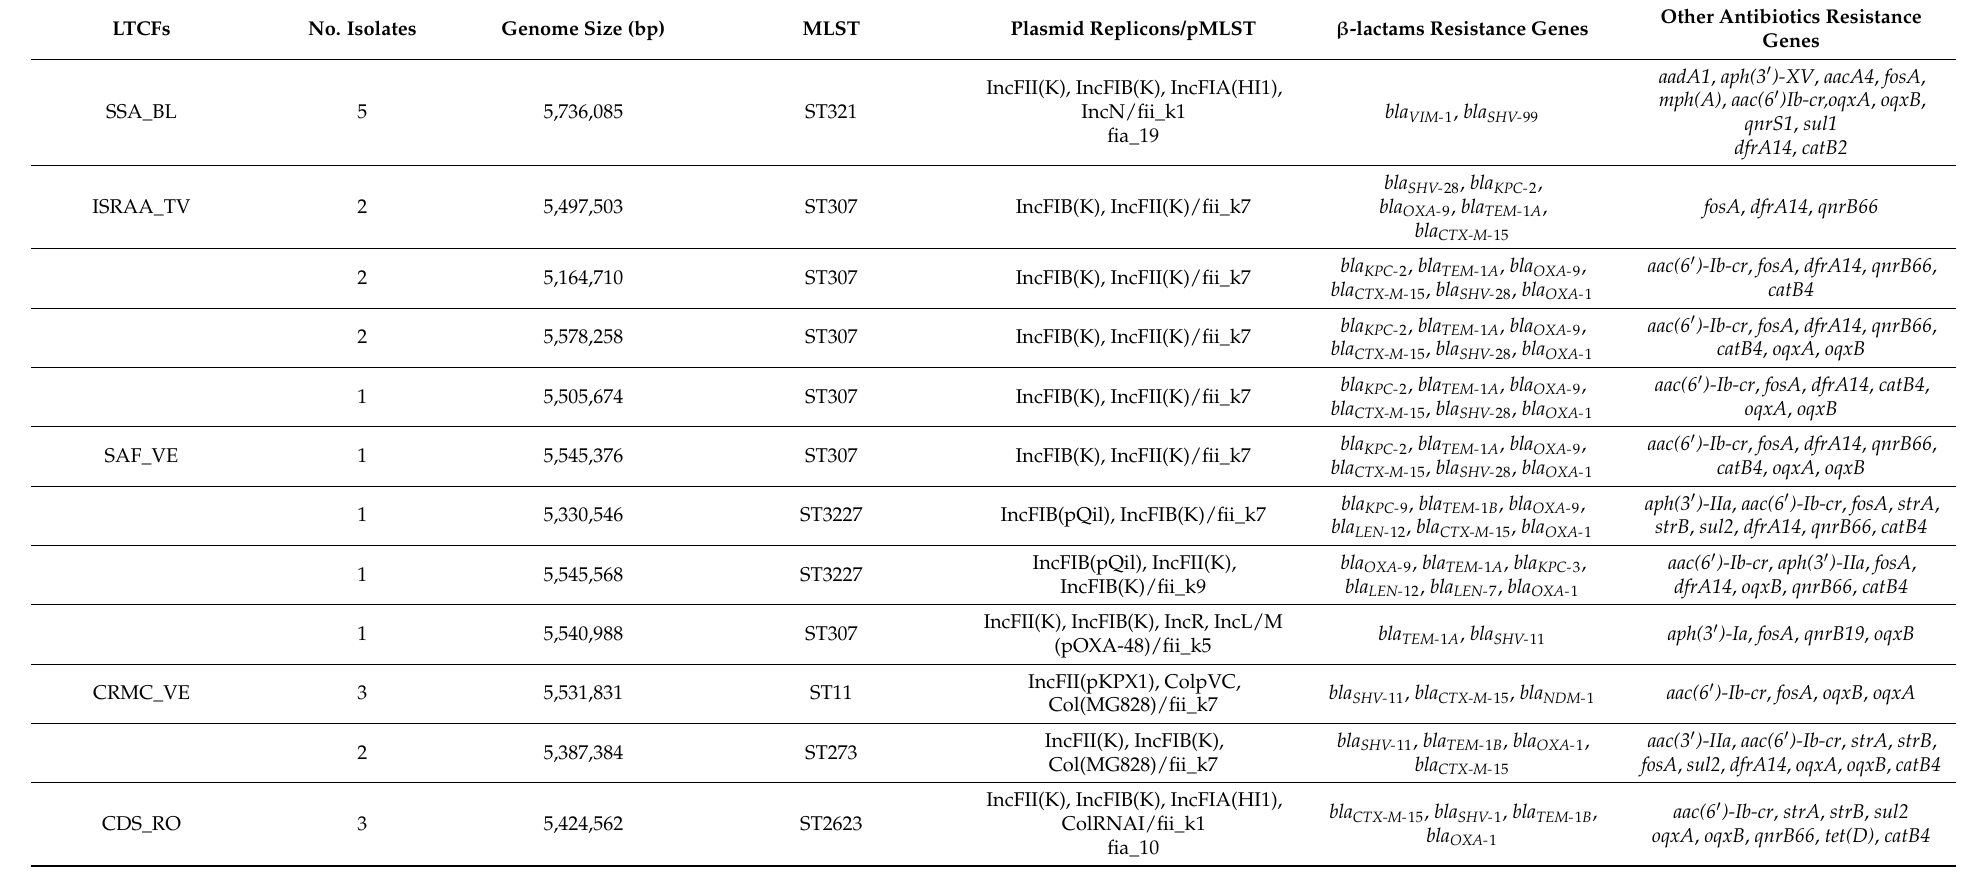
Table 2. Genome analysis of K. pneumoniae isolated from residents of twelve LTCFs (Northern